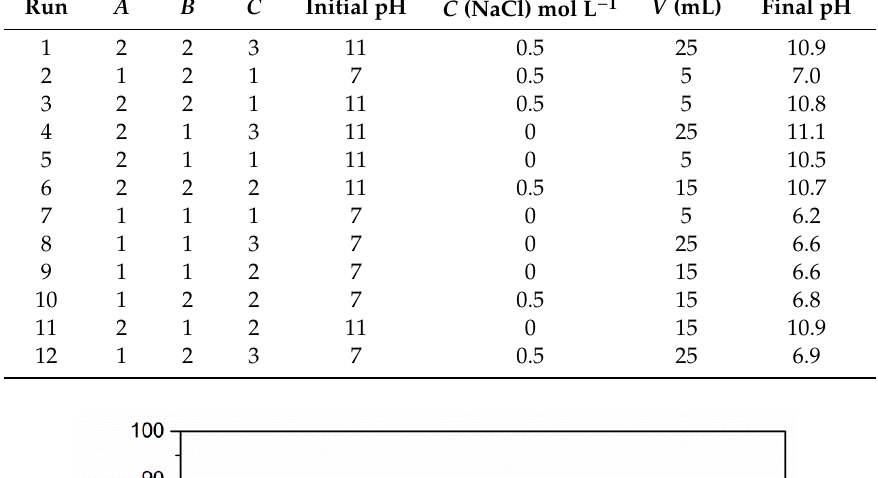
Table 2. Experimental design matrix.